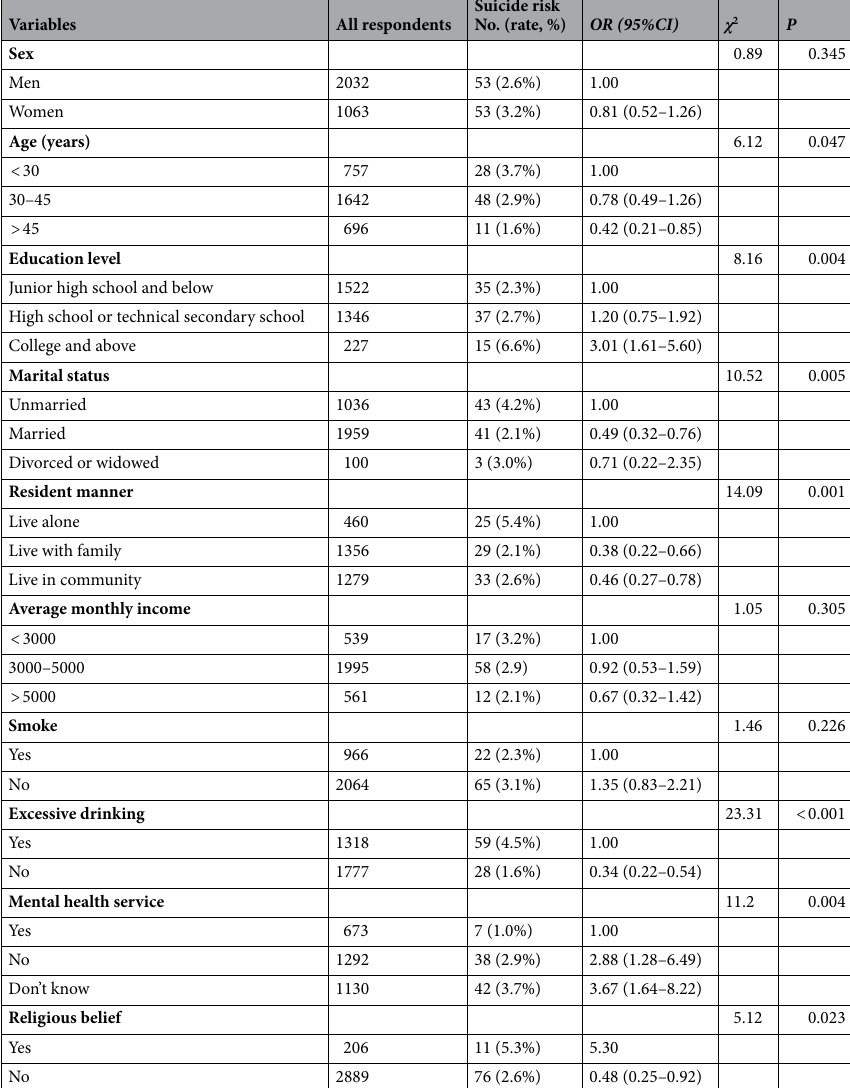
Table 1. Comparison of suicide risk among migrant workers with different socio-demographic characteristics [n